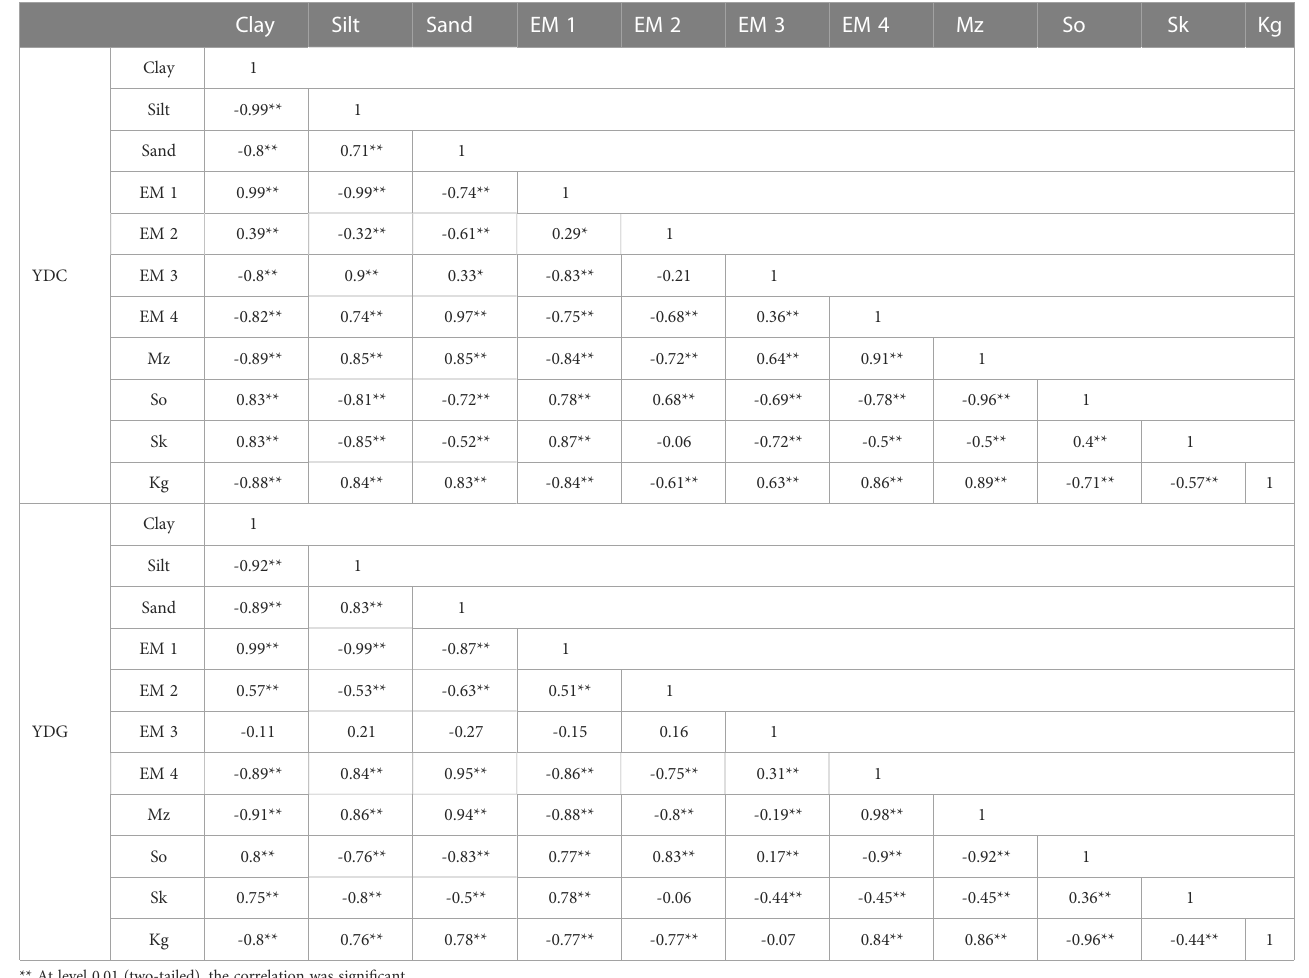
TABLE 2 Correlation analysis of each grain-size end member with grain-size components and parameters of cores YDC and YDG.